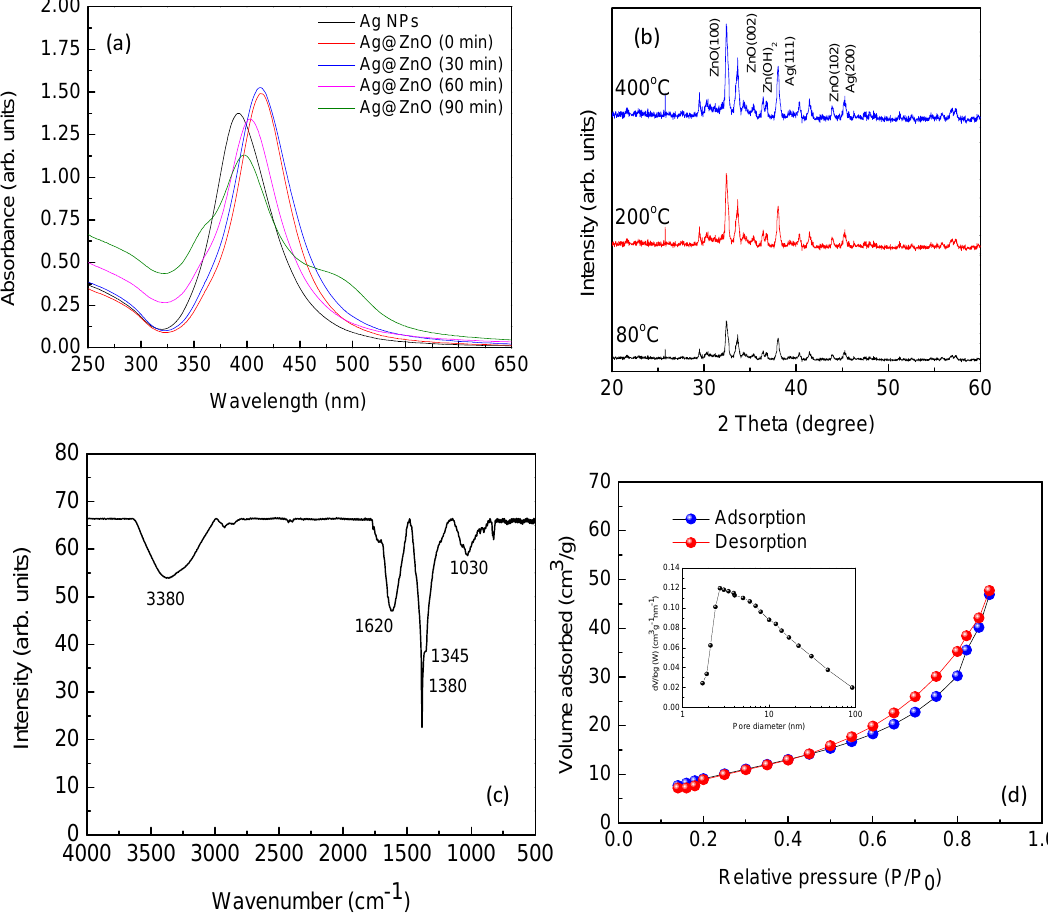
Figure 1. UV ‐ Visible spectra of aqueous dispersion of Ag and Ag@ZnO core ‐ shell nanoparticles ( a ), XRD pattern ( b ) and FTIR spectrum ( c ) of Ag@ZnO core ‐ shell nanoparticles, ( d ) Nitrogen adsorption/desorption isotherms obtained at 77 K and inset shows the pore size distribution of the as ‐ synthesized Ag@ZnO NCs synthesized by the sonochemical technique and dried at 80 °C for 2 h.